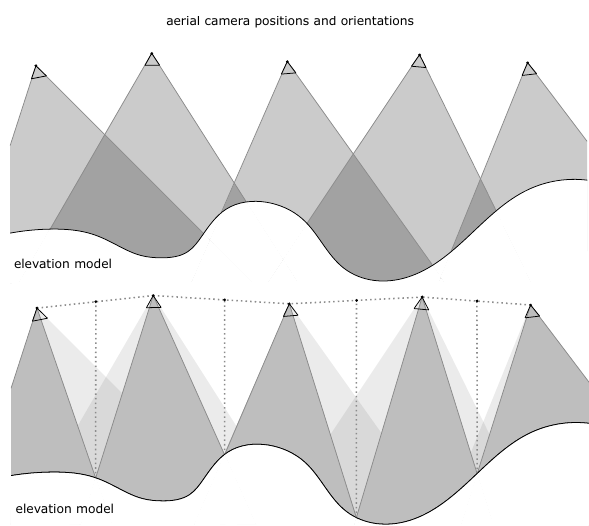
Figure 2. Aerial imaging of mountainous terrain and overlap vi- sualization of its view cones (profile view). Upper figure: full frame coverage and view cone overlap. Lower figure: minimized view cone overlap of clipped aerial images by application of TAC